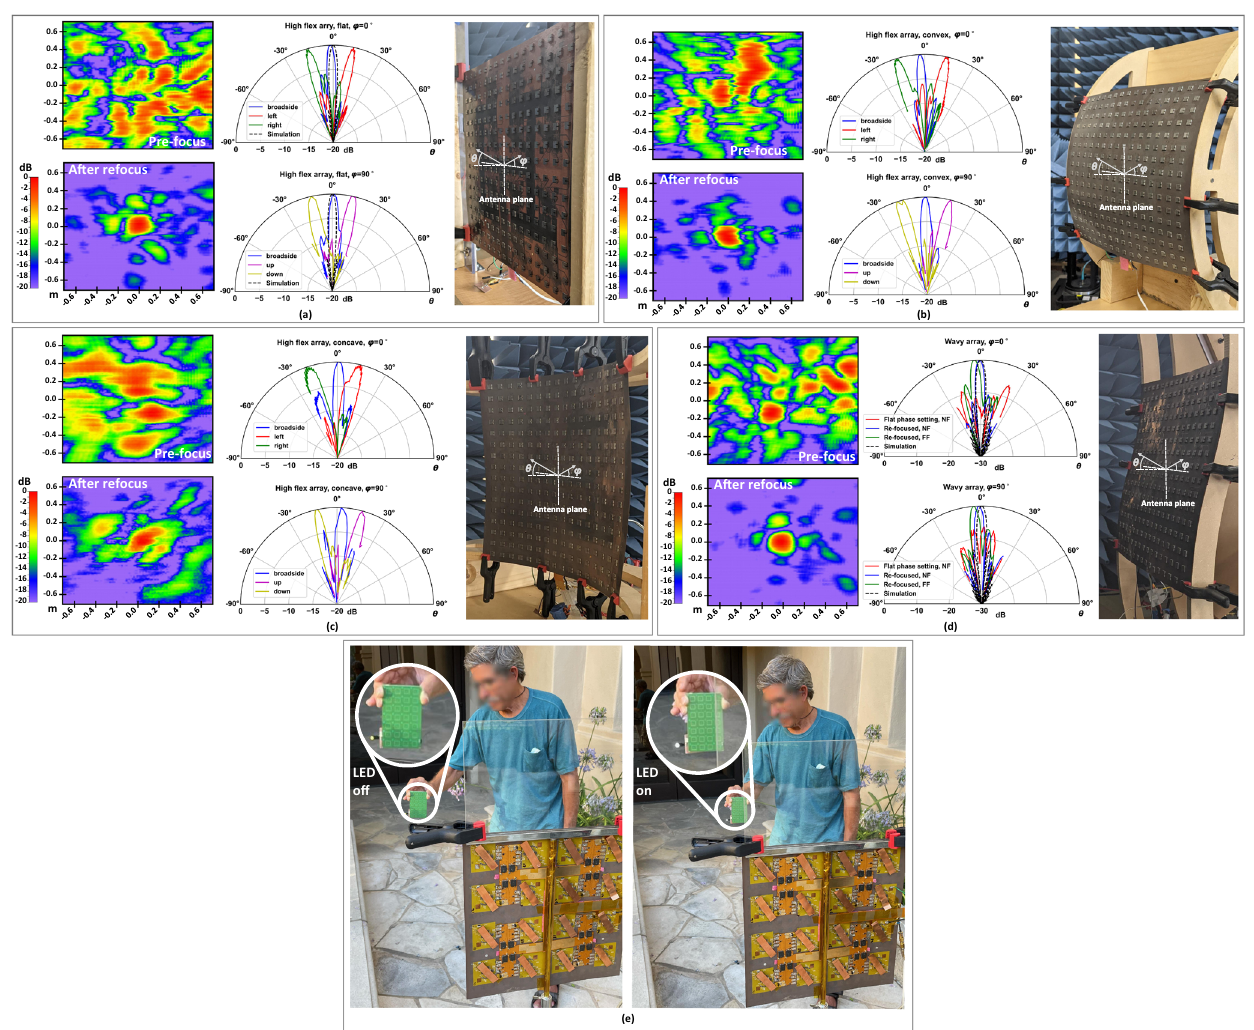
Fig. 6 Flexible array measurements, demonstrating bend radii <23 cm. Figures a – d include pre- and post-focusing 2-D near- fi eld radiation patterns (left), beam-steering of the main lobe (center), and array formation (right). a 2-D beam-steering with fl exible array in planar con fi guration. b 2-D beam-steering with fl exible array in convex con fi guration. c 2-D beam-steering with fl exible array in concave con fi guration. d 2-D beam-steering with fl exible array conformed to a doubly curved shape. e Outdoor deployment and focusing to power an LED indicator. The LED is on when the receiver is at the focus point (right) and off when moved away from it deformation. After refocusing, the receiver voltage is only 0.3 dB (Fig. 6b and c) broadside-focused lobes are with an HPBW as lower than the value obtained from fl at broadside expected, but the steered lobes are affected by bending, with optimization – within measurement tolerance. Worst case side average HPBW of 6.4 ∘ and 6.7 ∘ , respectively. This is partly the result lobes in our steering experiments are at about − 7 dB and are a of increased non linear coupling effects between neighboring mostly a results of re fl ections due to near- fi eld focusing. Figure 6d synthesizers and between neighboring power ampli fi ers that drive also illustrates how the mathematical near- to far- fi eld conversion each radiator. Such coupling cannot be accounted accurately by results a deviation of the lobe center from the near fi eld pointing the iterative focusing process. In addition, the short range direction. While this is not a fundamental problem, it highlights focusing results beam widening after the pattern is transformed the importance in understanding the geometric properties of to far- fi eld, and sampling effects cause ripples near the phase scan array focusing. Like the high-power implementation, this array is boundaries. For a comparison, HPBW of the raw, near- fi eld also capable of powering a remote pulse oximeter, but at a radiation patterns at the focusing distance, is 5.6 ∘ , 5.1 ∘ , and 5.9 ∘ reduced distance of 40 cm away from the radiator. The reduction for fl at, convex, and concave bends, respectively. It is noteworthy in power delivery range implies a reduced EIRP of the fl exible that bending the antenna results lower transmitted power implementation to ~52 dBm compared to the high-power light- compared to a fl at con fi guration. The receiver rectenna voltage weight antenna. The estimated EIRP value was veri fi ed by a direct after focusing is lower on average by 10% and 24% in convex and measurement. The dielectric patch array was focused at a target at concave bends, respectively, indicating average power density 6.2 m just beyond the far- fi eld threshold of 6 m. Accounting for decrease of 0.95 dB, and 2.3 dB, respectively. In a follow-up mixed path loss, transmission at ~10 GHz and a horn antenna with a experiment we bent the fl exible array to a doubly curved shape known receiver gain of 11 dBi, the measured EIRP is 52.7 dBm. The and directed it at an angle from the receiver. Figure 6d illustrates reduced EIRP is a result of the design choice to optimize fl exibility how focusing can correct the radiation pattern under a physical